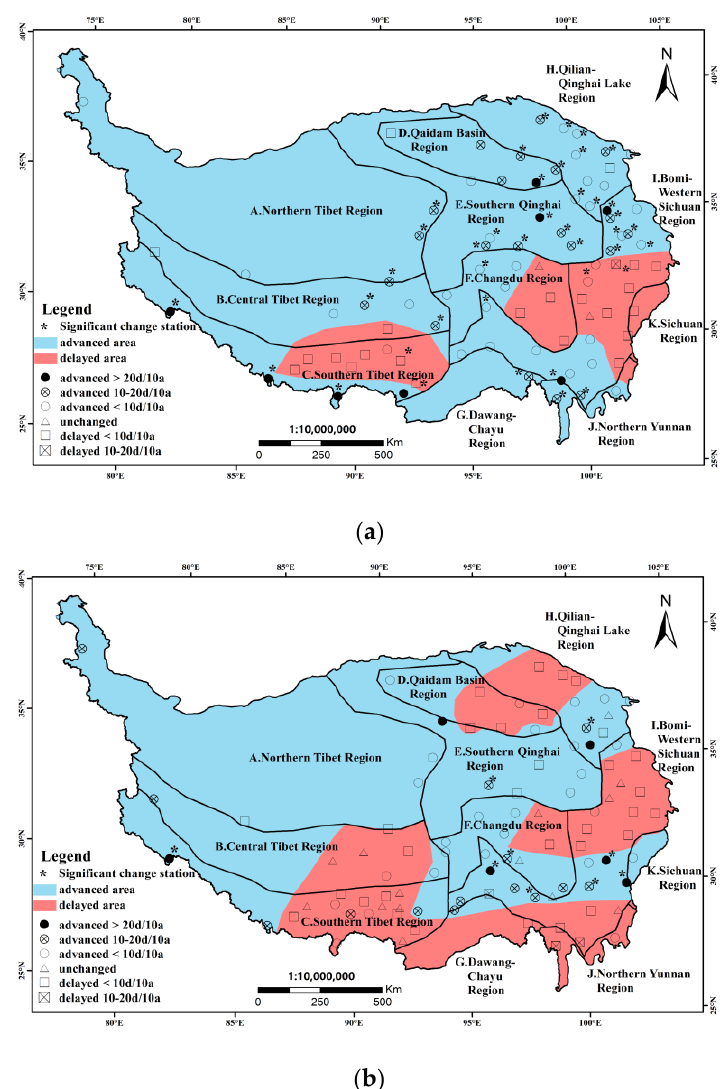
Figure 6. The differences in the trend in the rainy season onset for each station ( a ) before mutation; ( b ) after mutation.